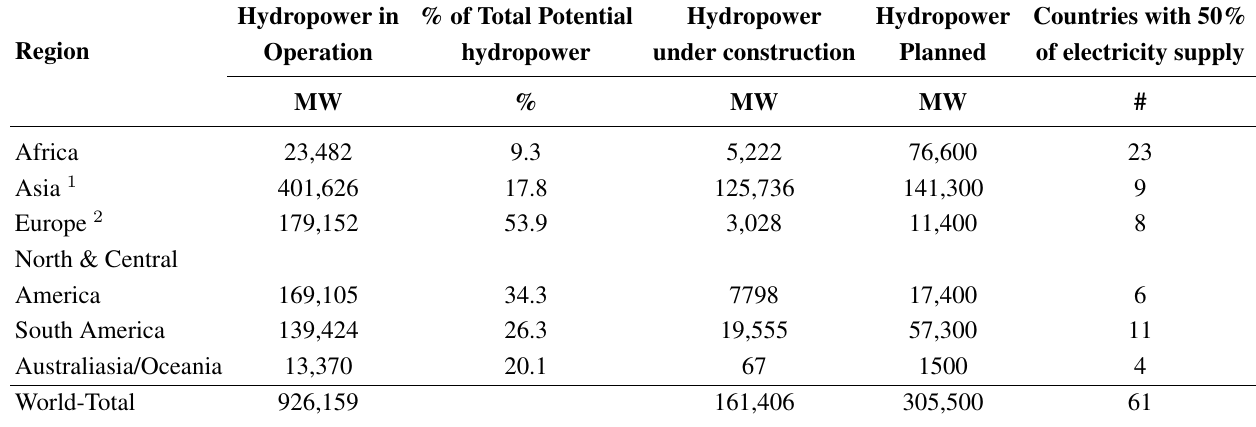
Table 1. World Hydropower in operation, under construction and Planned [3].